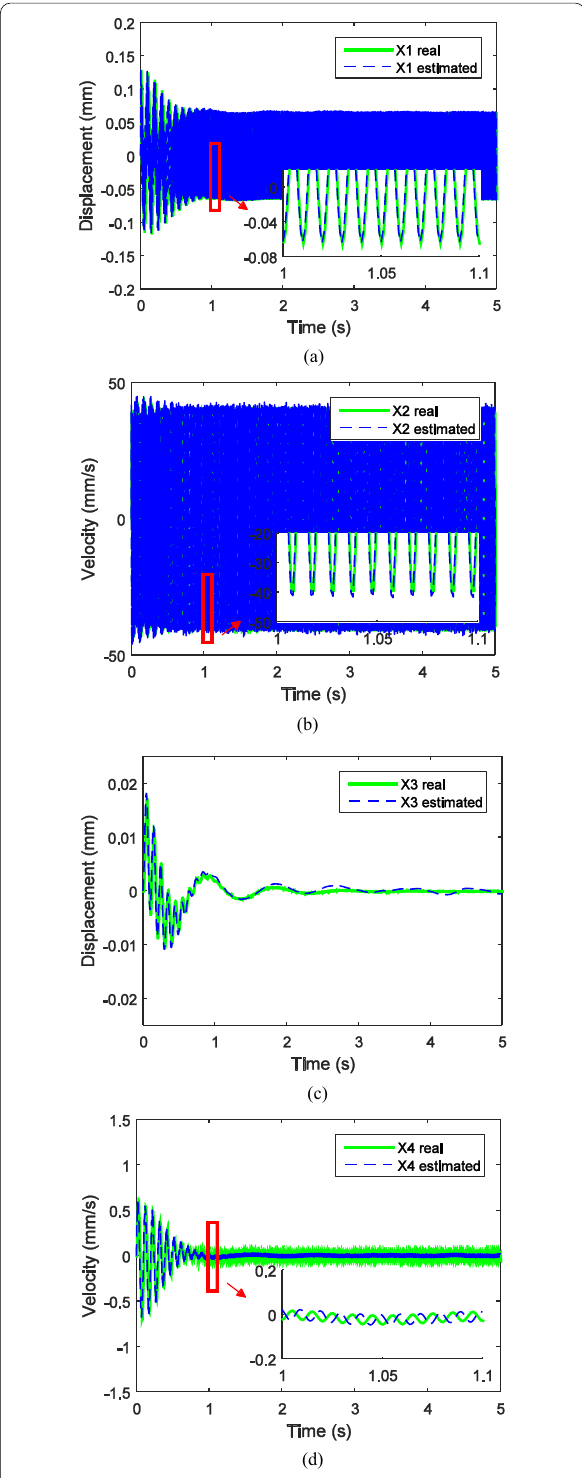
Figure 11 Comparison between estimated system state and real system state at the engine speed of 3000 r/min: a X 1 : engine displacement, b X 2 : engine velocity, c X 3 : sprung mass displacement, and d X 4 : sprung mass